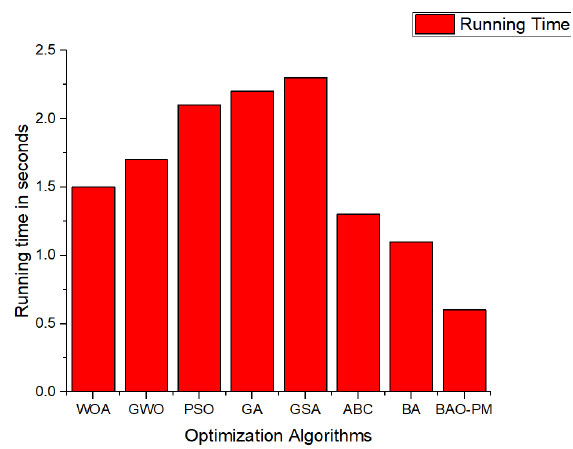
Figure 13. Comparison of accuracies by different classifiers for different datasets.